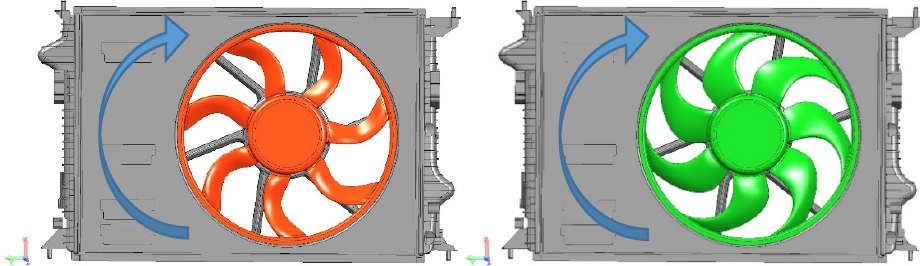
Figure 2. Backward and forward curved blades (blue arrows: rotational direction).